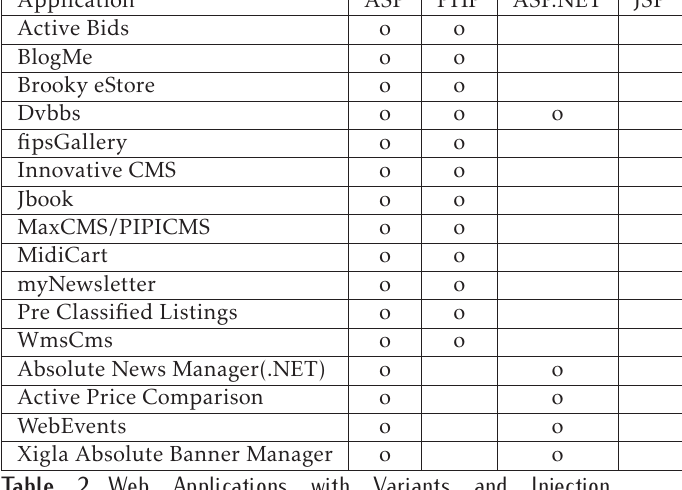
Table 2. Web Applications with Variants and